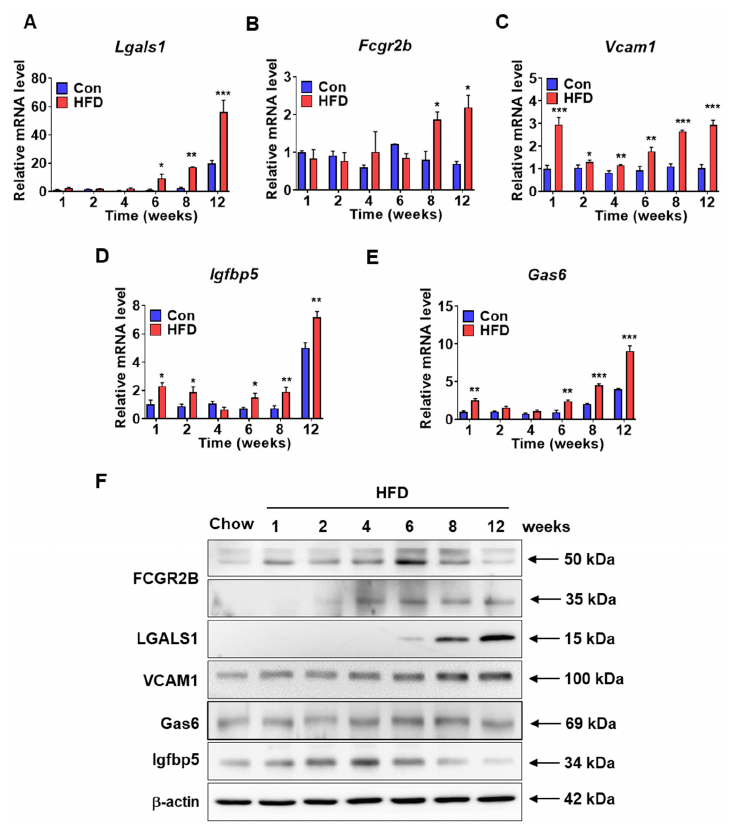
Figure 6. Expression levels of the selected pre-DM bio-markers in the liver samples of control and HFD-fed WT mice: ( A – E ) mRNA expression of Fcgr2b, Lgals1, Vcam1, Igfbp5, and Gas6 in the liver from control and HFD-fed WT mice ( n = 5). ( F ) Protein lysates from the livers of control and HFD- fed WT mice were immunoblotted with indicated antibodies. β -actin was used as a loading control ( n = 5). * p < 0.05, ** p < 0.01, and *** p < 0.001 control vs. HFD-fed WT mice at the respective weeks. Fcgr2b: Fc receptor, IgG, low affinity Iib, Lgals1: lectin, galactose binding, soluble 1, Vcam1: vascular cell adhesion molecule 1, Igfbp5: insulin-like growth factor binding protein 5, Gas6: growth arrest- specific 6.